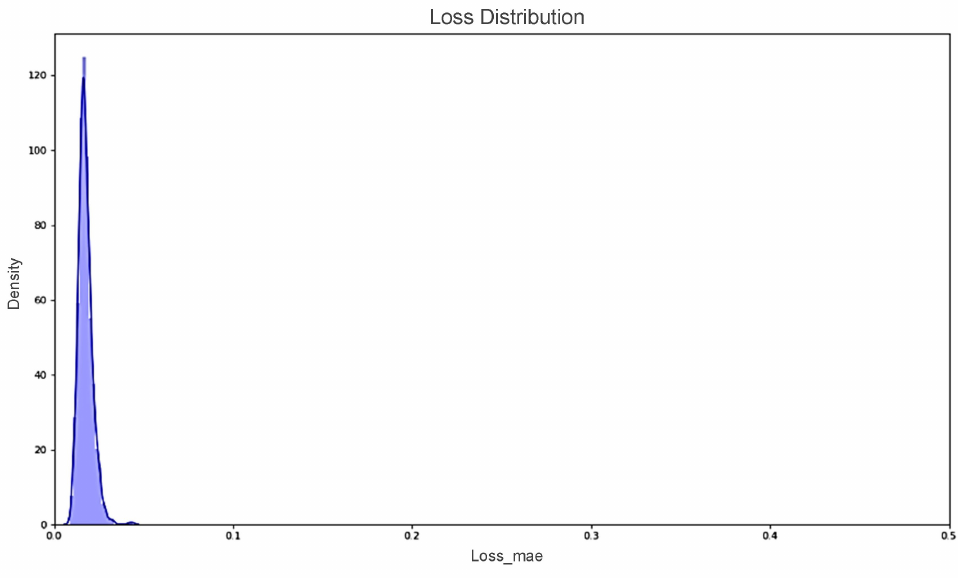
Figure 16. Distribution of loss values by applying the CAE model to SSA data.